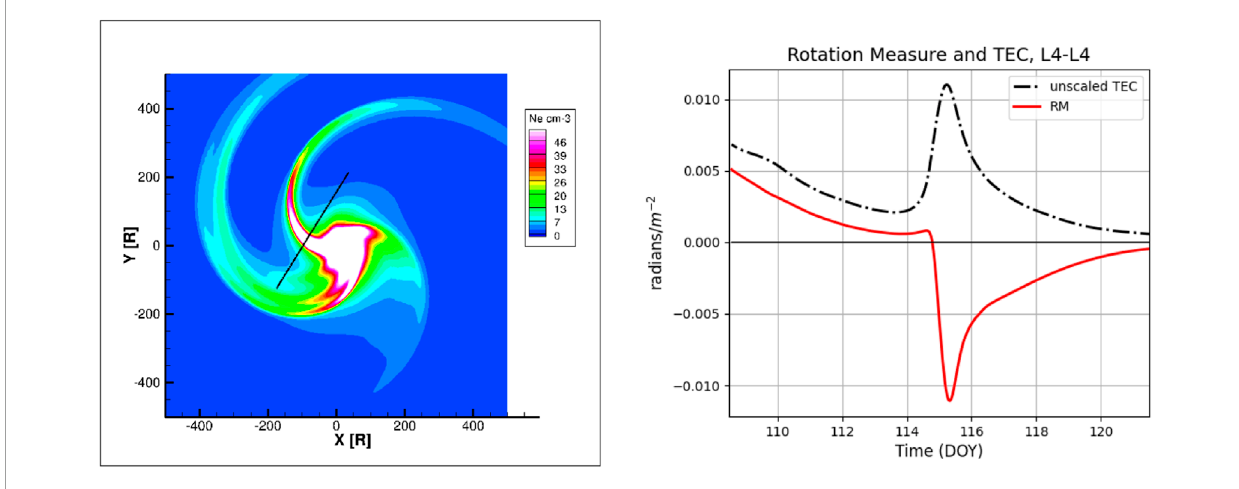
FIGURE 3 Left: AWSoM simulation of heliospheric density for CR2109. The spiral SIRs appear in enhanced density in the solar equatorial plane. The FETCH L4–L5 LOS (line 1 in Figure 1 ) is oriented approximately transverse to the SIR, where TEC reaches a minimum. Right: the FR and TEC (shown in solid red and black dot-dash, respectively) are observed as the rotation advancement brings the SIR across the FETCH L4–L5 LOS. An unscaled, concurrent TEC curve shows a similar placement of the peak but contrasts with the RM curve in its rate approaching zero.